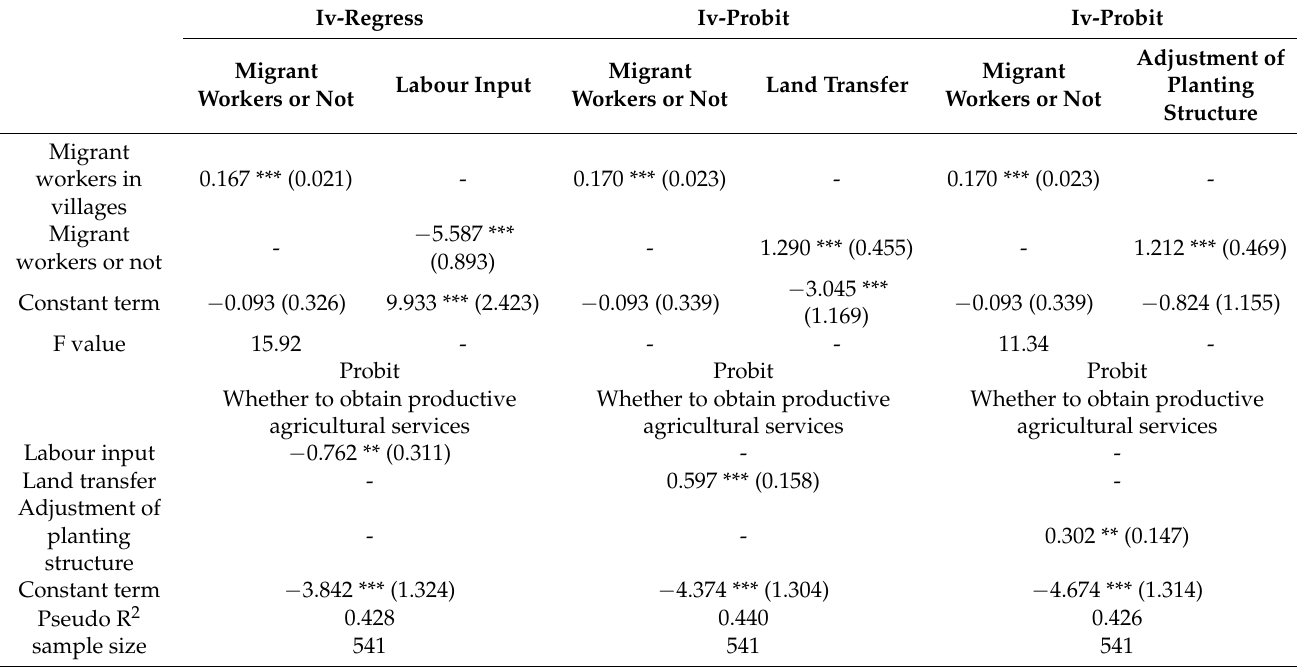
Table 3. Estimation results of the conduction mechanism